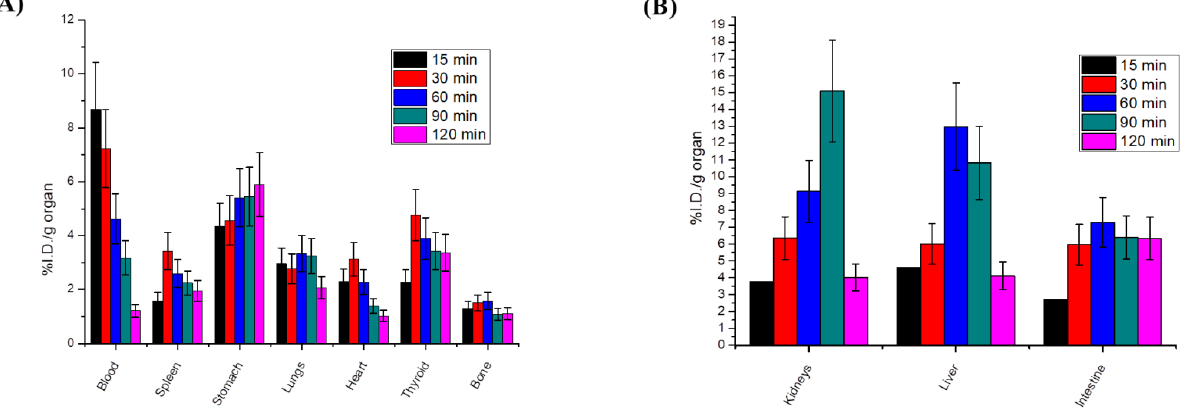
Figure 10. Percent injected dose per gram organ of the radioiodinated- 4i compound in sarcoma- bearing mice model in ( A ) non-target organs and ( B ) excretory organs.